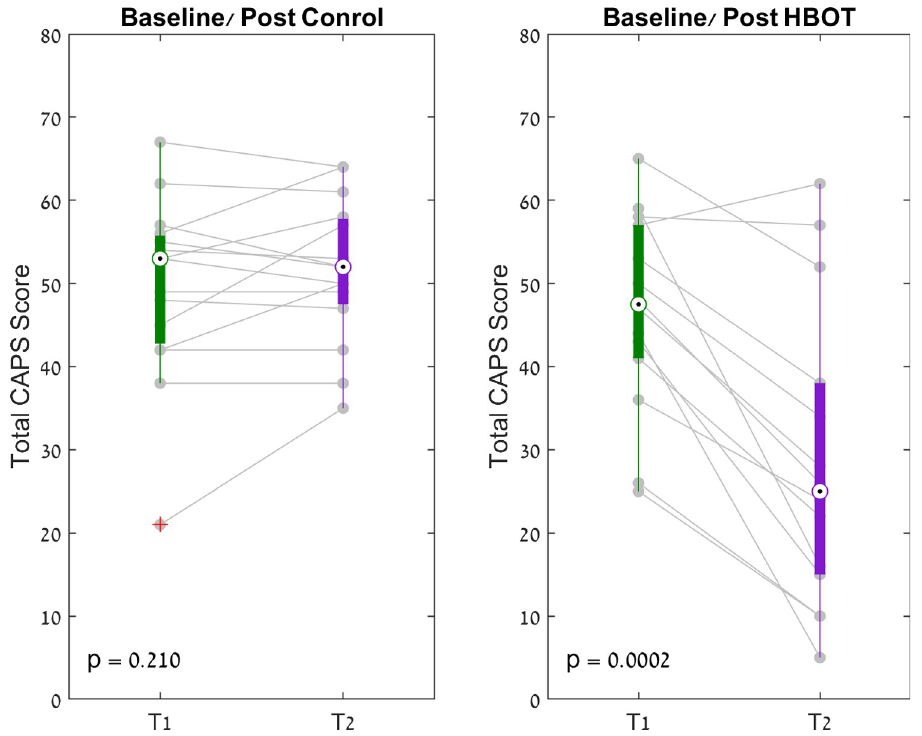
Fig 2. CAPS scores paired box plot. The central mark indicates the median, and the bottom and top edges of the box indicate the 25th and 75th percentiles, respectively. + Symbols indicate outliers.